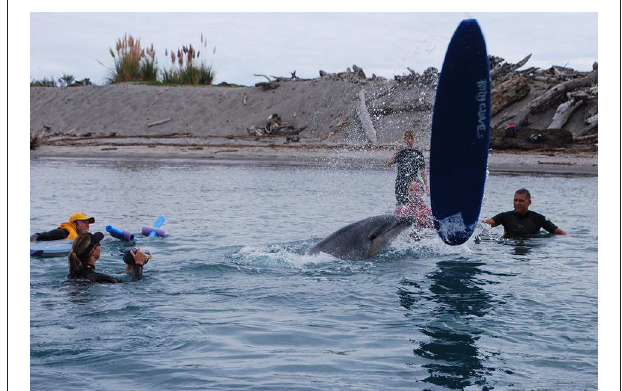
FIGURE 7 | “Moko” playing with a surfboard by pushing it underwater to make it shoot up into the air (Photo: Ingrid Visser).